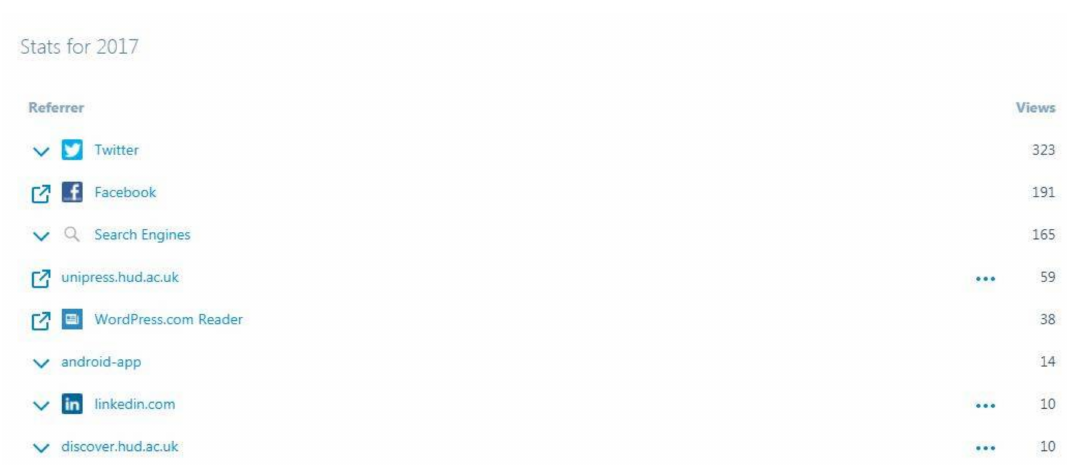
Figure 2. Blog referrers for